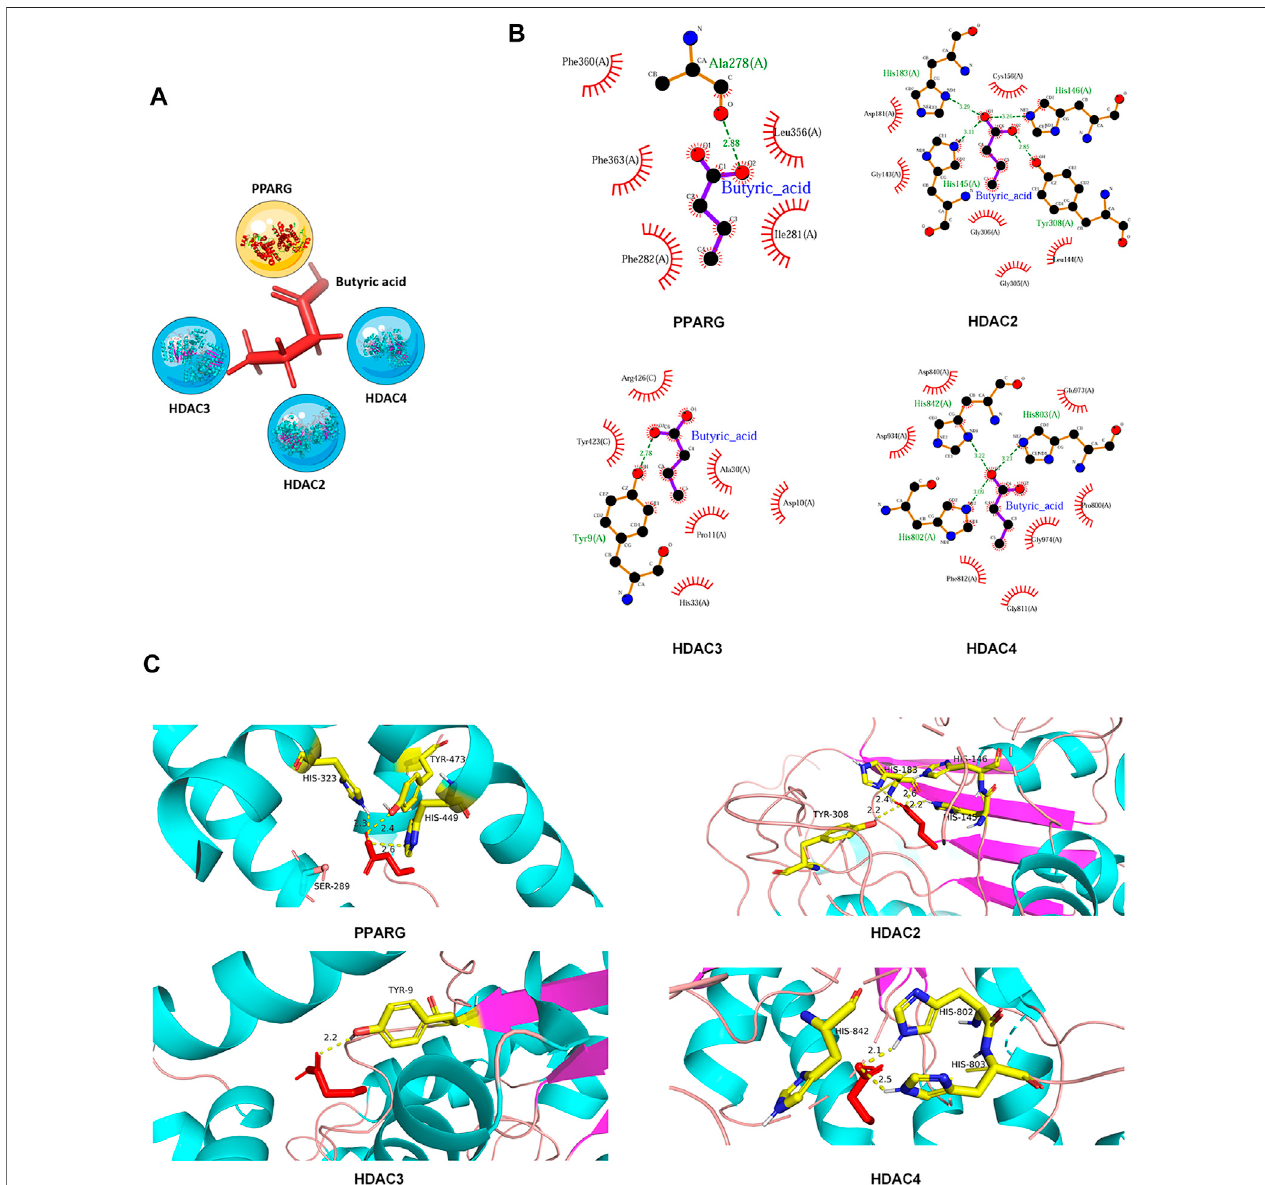
FIGURE 5 | PPARG and HDACs can interact with butyric acid. (A) Network of interaction among PPARG, HDACs and the metabolite-butyric acid. (B) 2D and (C) 3D versions of the molecular docking of butyric acid to PPARG, HDAC2, HDAC3, and HDAC4.